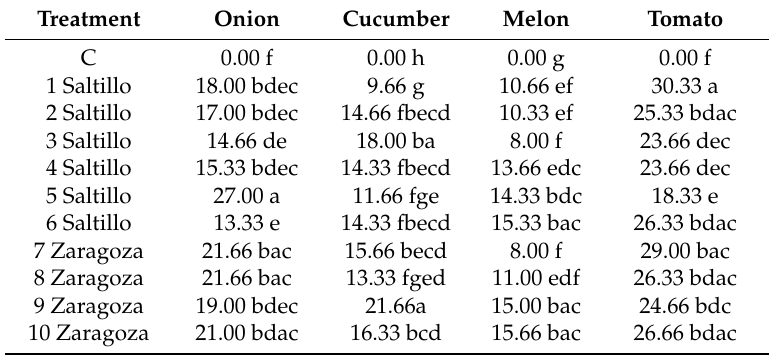
Table 3. Average density of spores (Tukey’s p ≤ 0.05) in four horticultural